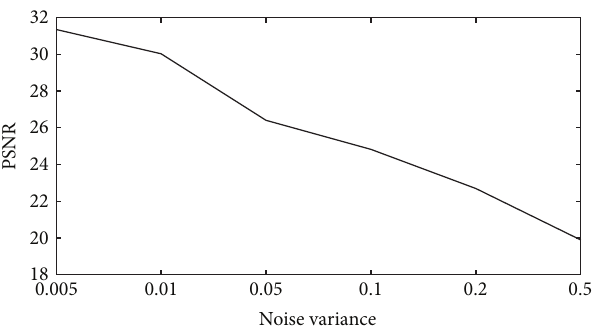
Figure 11: The PSNR values obtained by the proposed method under different noise